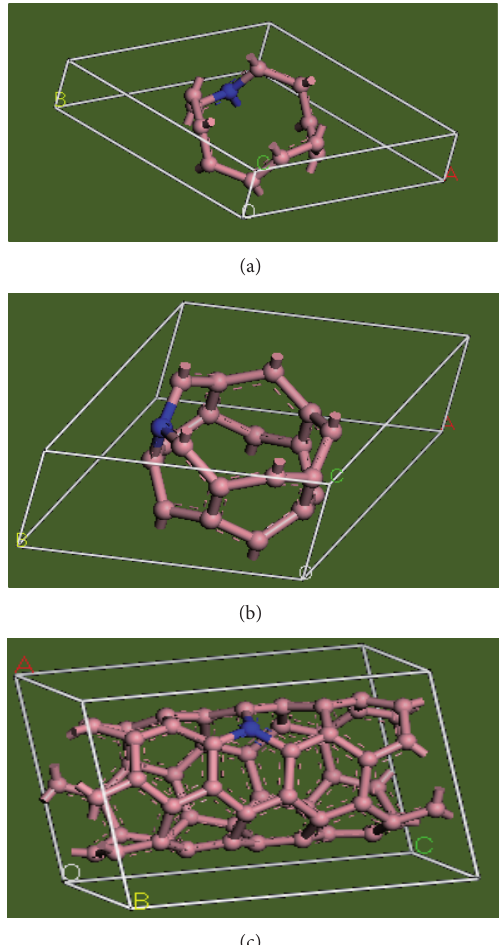
Figure 1: The ball and stick model of single atom of nitrogen doped for (a) armchair (3,3), (b) zigzag (5,0), and (c) chiral boron nanotubes. The encircled blue atom is of nitrogen while brown is of